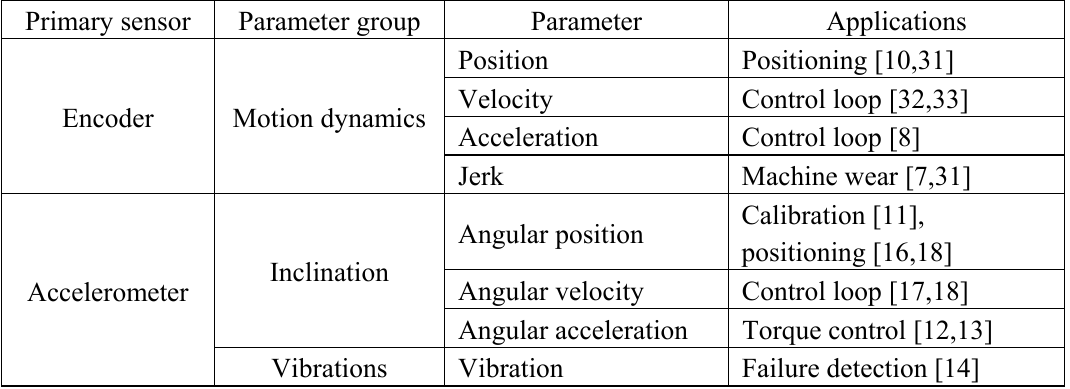
Table 2. Smart sensor parameter application